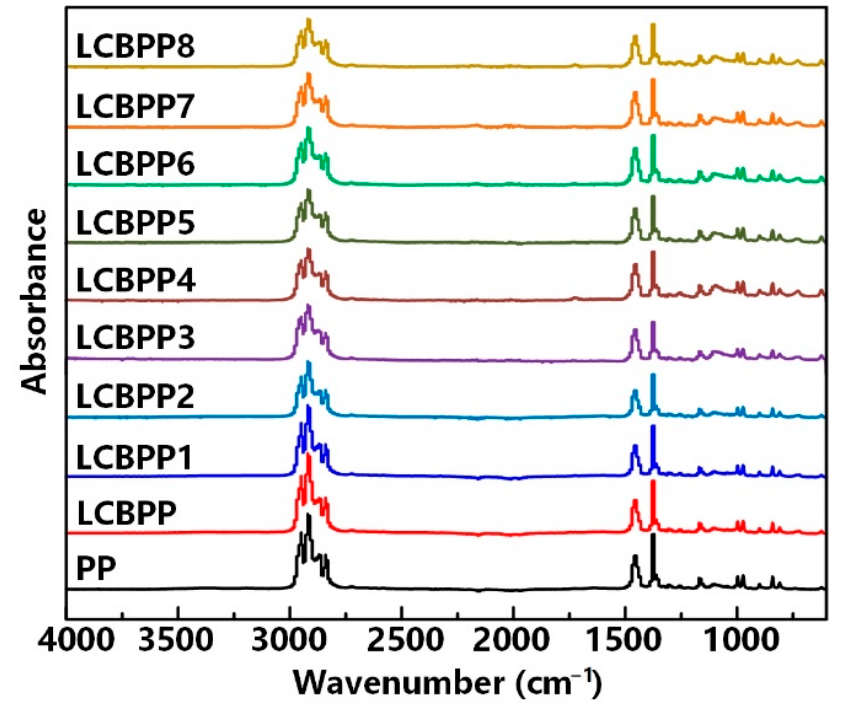
Figure 3. The FTIR characterization of the test samples.